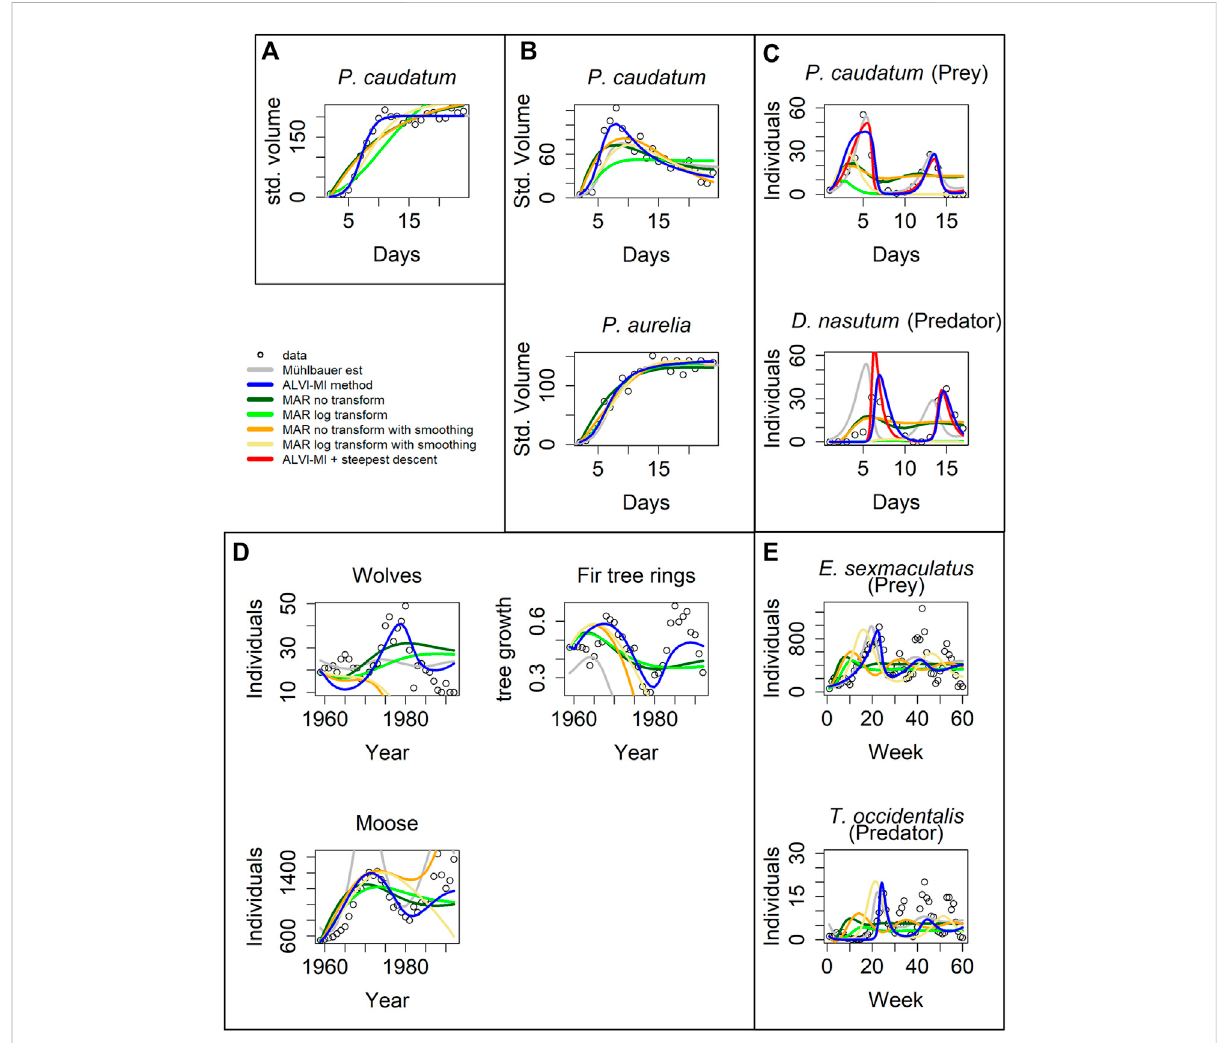
FIGURE 4 Model inferences associated with Gause ’ s data (Gause, 1934). (A) Standardized volume of Paramecium caudatum grown in monoculture. (B) Standardized volume of Paramecium caudatum and Paramecium aurelia grown in mixed population. (C) Predator-prey interactions between Didinium nasutum and Paramecium caudatum grown in mixture. (D) Multi-trophic dynamics for wolves, moose, and fi r trees on Isle Royale from 1960to1994. (E) Predator-preyinteractionsbetweenEotetranychus sexmaculatusandTyphlodromusoccidentalis.Circlesshowobservations, gray lines are estimates from Mühlbauer et al. (2020). LV estimates are presented as blue lines and MAR estimates as green, orange and yellow lines. Redlinesin (C) correspondtoasteepestdescentoptimizationusingthesolutionofALVI-MIasinitialguess.SeeTextandSupplementaryTablesS4.1, S4.3 for further